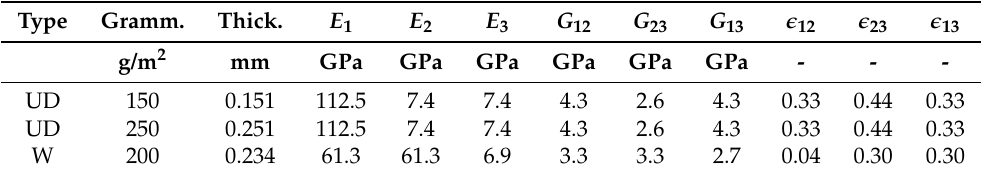
Table 5. Orthotropic elasticity of CFRP prepregs used to manufacture the upper blade, middle blade and lower